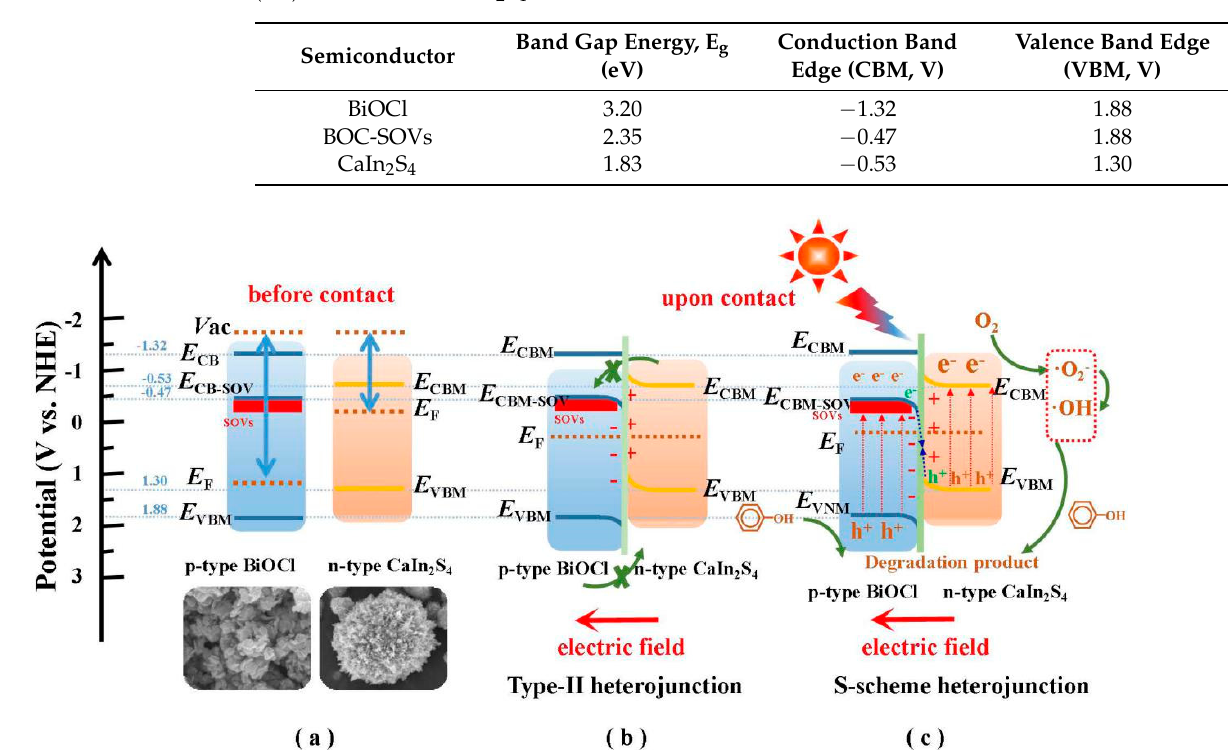
Table 3. The estimated bandgap energy (Eg), conduction band edge (CB), and valence band edge (VB) for BiOCl and CaIn 2 S 4 .